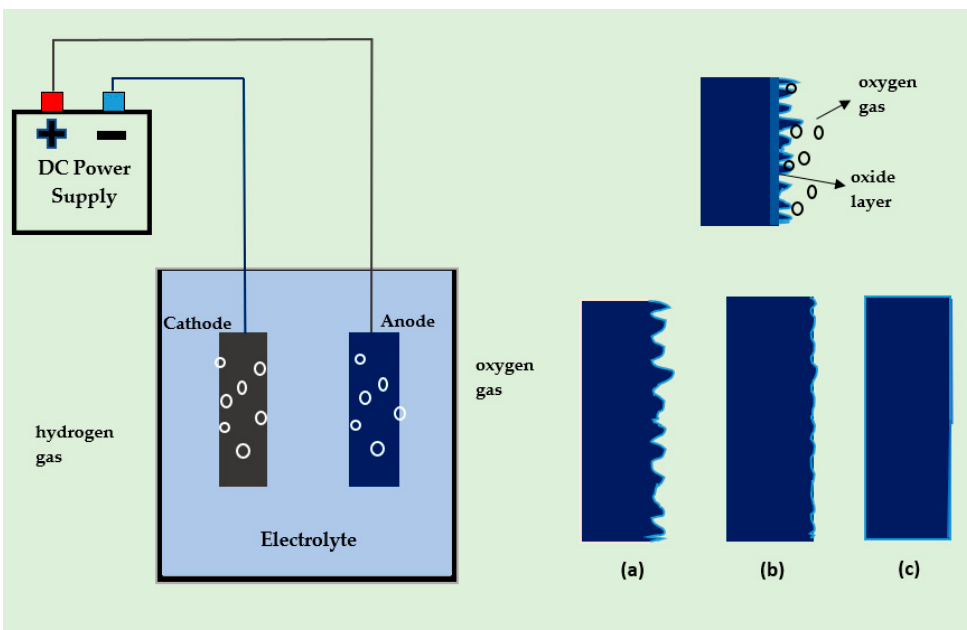
Figure 1. The basic setup of an electropolishing cell, showing how the surface of a workpiece changes from being initially uneven to being smooth, ( a ) Initial uneven surface of the workpiece, ( b ) Macro-levelling/finishing, ( c ) Micro-levelling/finishing (after Lee 2000 and Wang 2016 [18,19]).